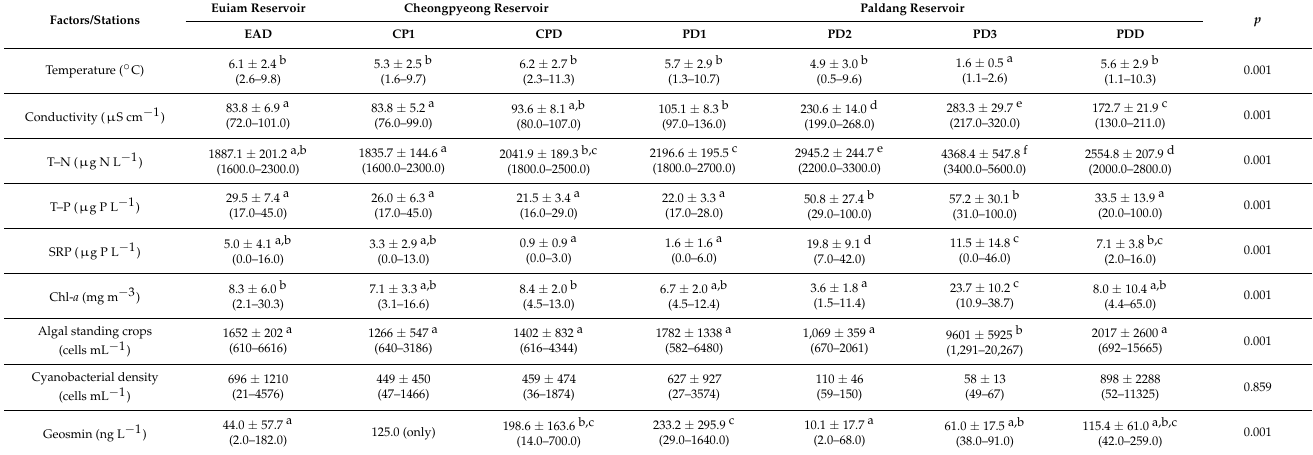
Table 3. Descriptive statistics of the daily water quality factors determined in the major stations of three reservoirs in the North Han River and Han River basins from 28 November 2011 to 4 January 2012. The values indicate means, standard deviations, and ranges (minimum and maximum). The results of Tukey’s test are represented by a – f , where stations with different letters are statistically different from each other ( a > b > c > d > e > f ) and stations that share the same letters are statistically similar. Data were obtained from the Ministry of Environment (MOE) and Korea Water Resources Corporation. Refer to Figure 1 for the locations of the different monitoring